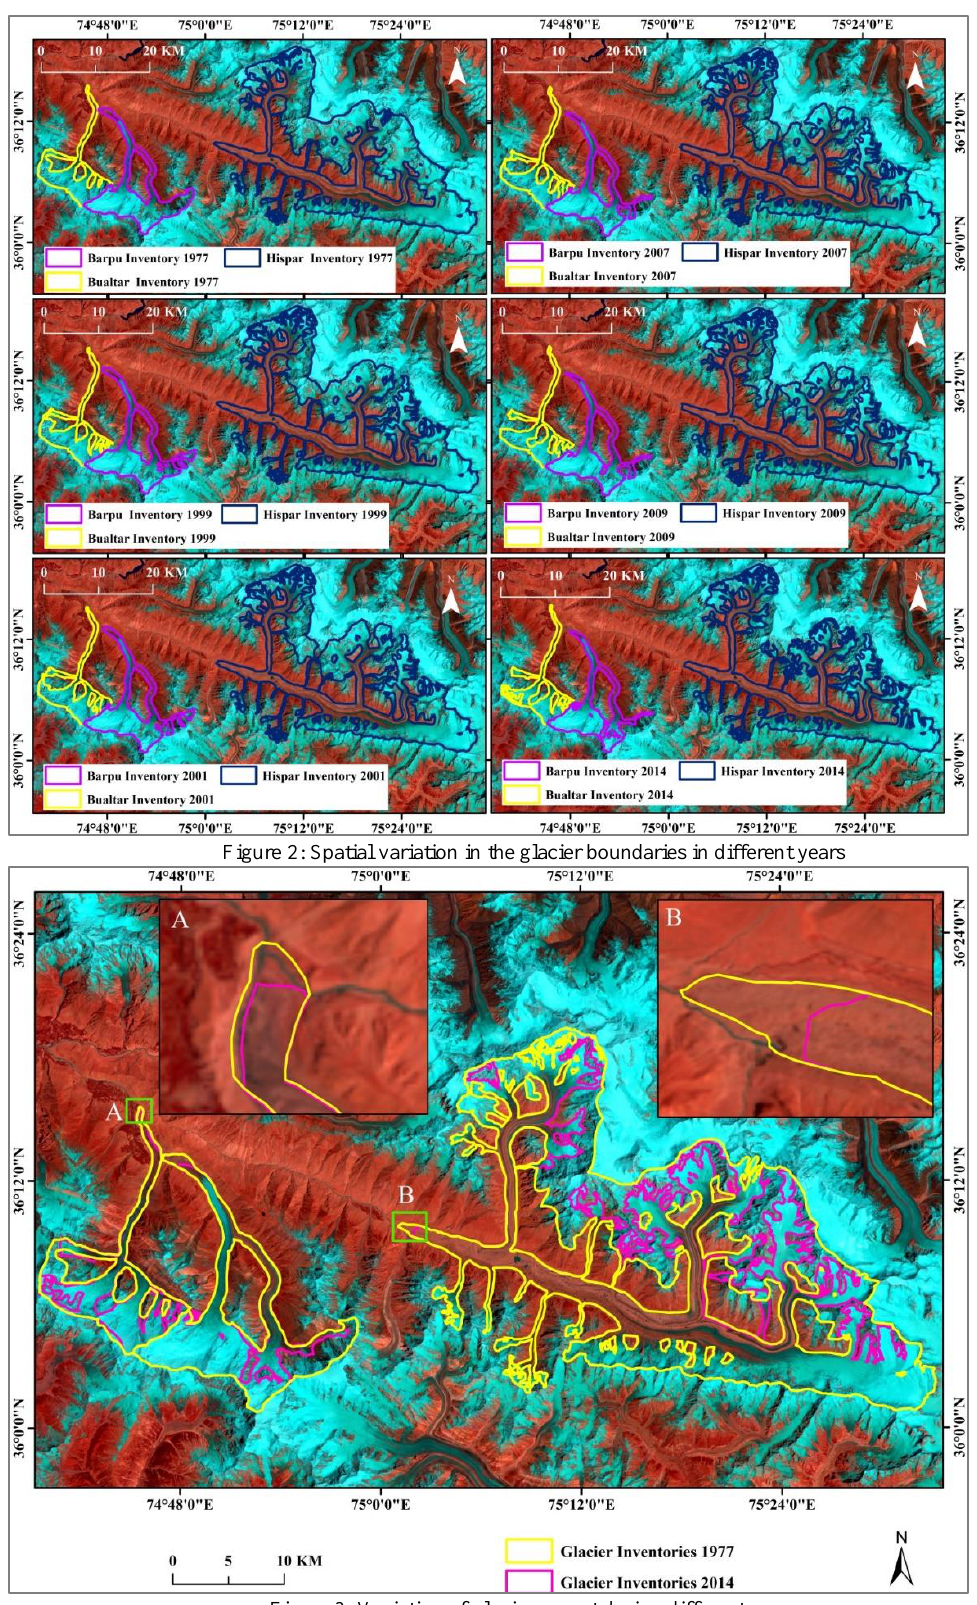
Figure 3: Variation of glaciers snout during different